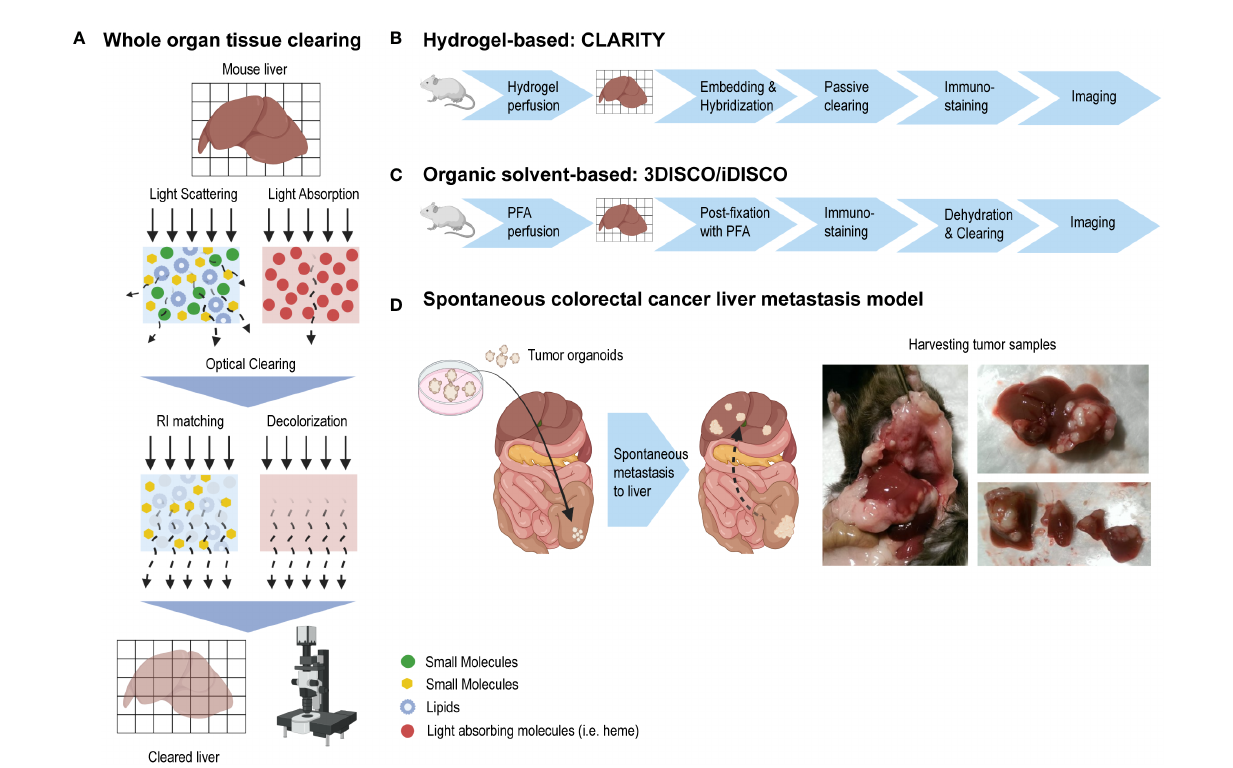
FIGURE 1 Whole organ tissue clearing using CLARITY and 3DISCO/iDISCO methods. (A) A tissue ’ s opacity is mainly caused by light scattering (due to the heterogeneity of the tissue components optical characteristics or refractive indexes) and light-absorbing compounds such as heme. Light scattering and light absorption hinder the light as it travels through a tissue. By using tissue clearing techniques, lipids are extracted and refractive indexes are better matched. Steps to remove light absorbing compounds are taken. The result is a “ transparent ” tissue in which microscopy imaging depth has greatly been improved. (B) CLARITY is a tissue clearing method which uses a tissue-gel hybrid to support and maintain the tissue ’ s architecture. (C) 3DISCO and iDISCO methods do not make use of a hydrogel scaffold like CLARITY, but use organic solvents instead for optical tissue clearing. (D) In a murine model, colorectal cancer organoids were implanted into the mouse cecum, after which the tumor cells spontaneously metastasized to the liver. Liver tumor samples were harvested and used to establish a tumor tissue clearing